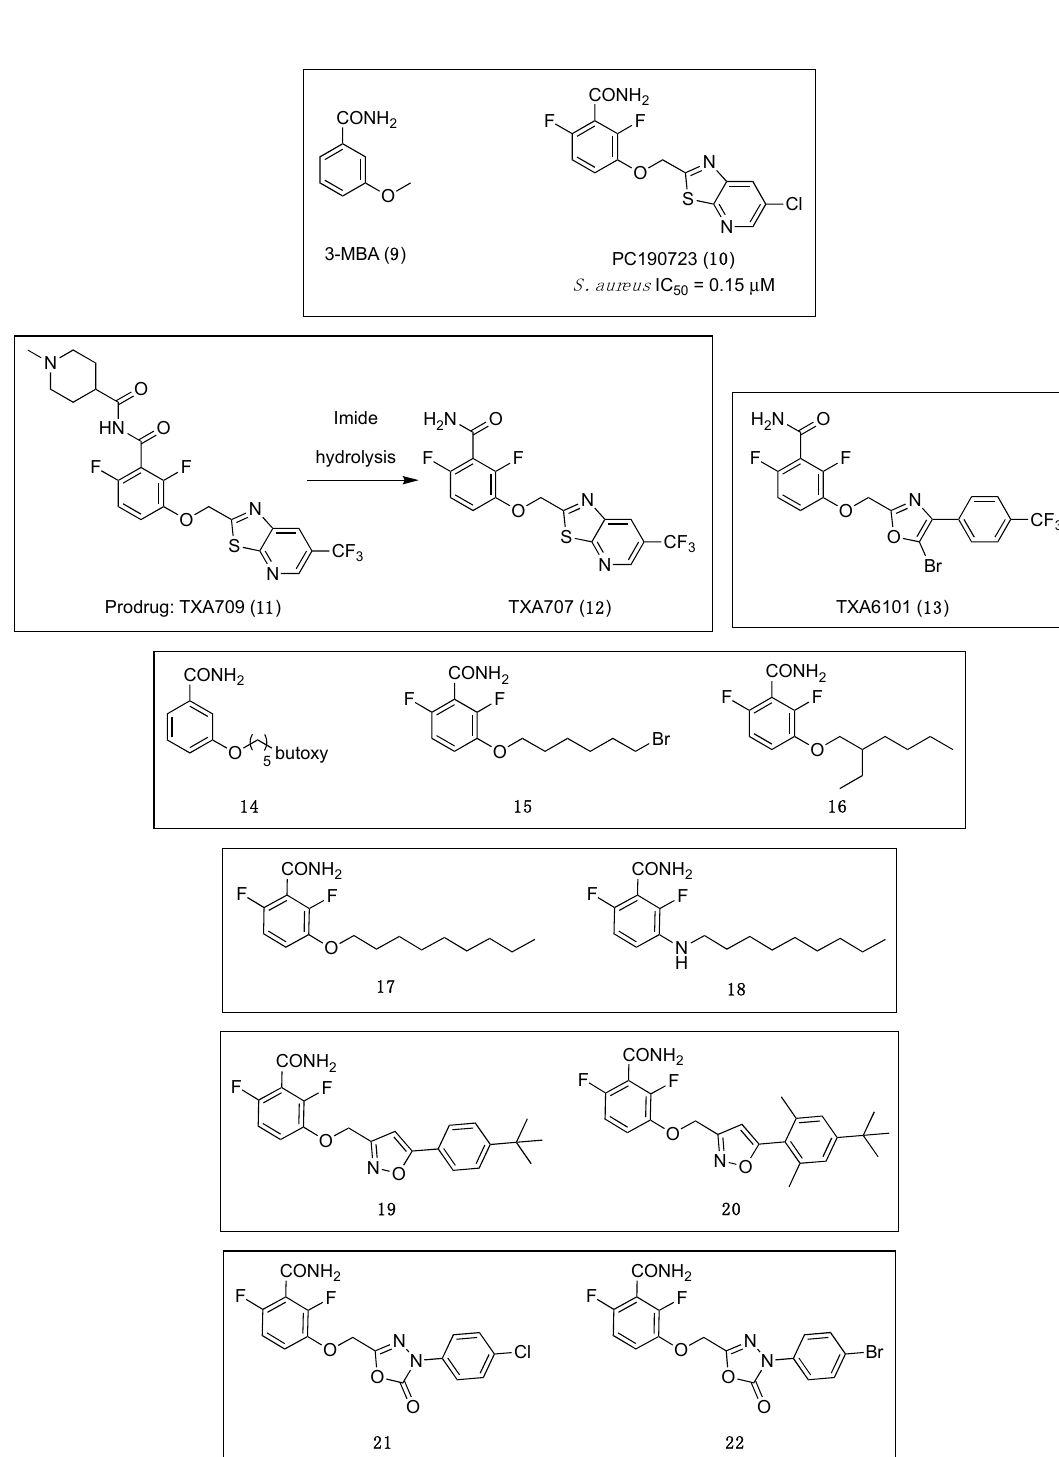
Figure 3. Chemical structures of the benzamide and structurally related derivatives. Table 1. Minimum inhibitory concentrations of the benzamide analogues.